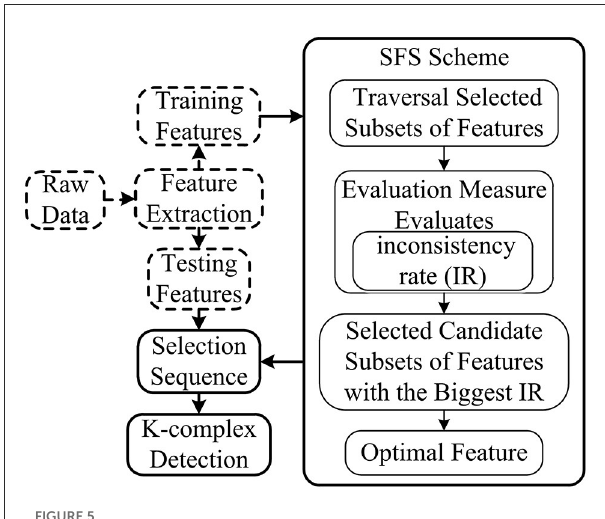
FIGURE5 Scheme of SFS. The dimension of feature subsets is reduced based on features selected by SFS, and the selected features are used for further analysis.